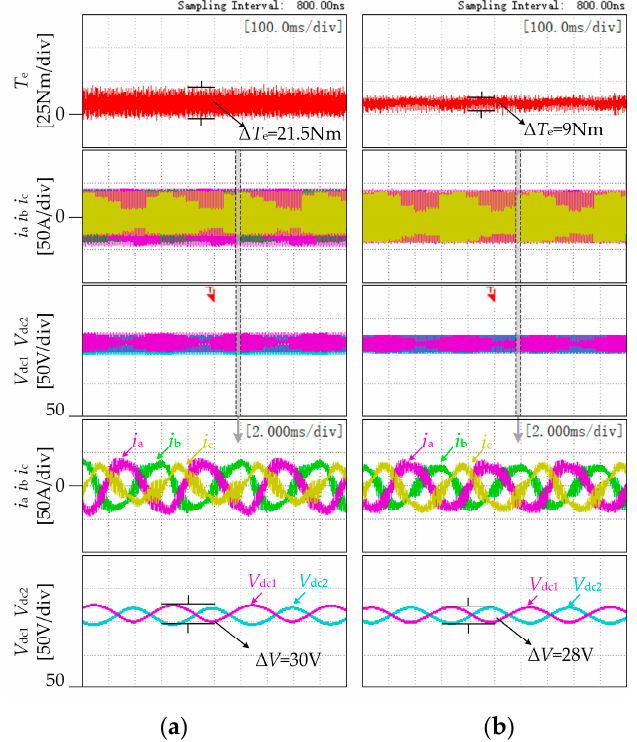
Figure 5. Experimental results at 2500 r/min and 10 Nm: ( a ) without capacitor voltage offset suppression; ( b ) proposed method.